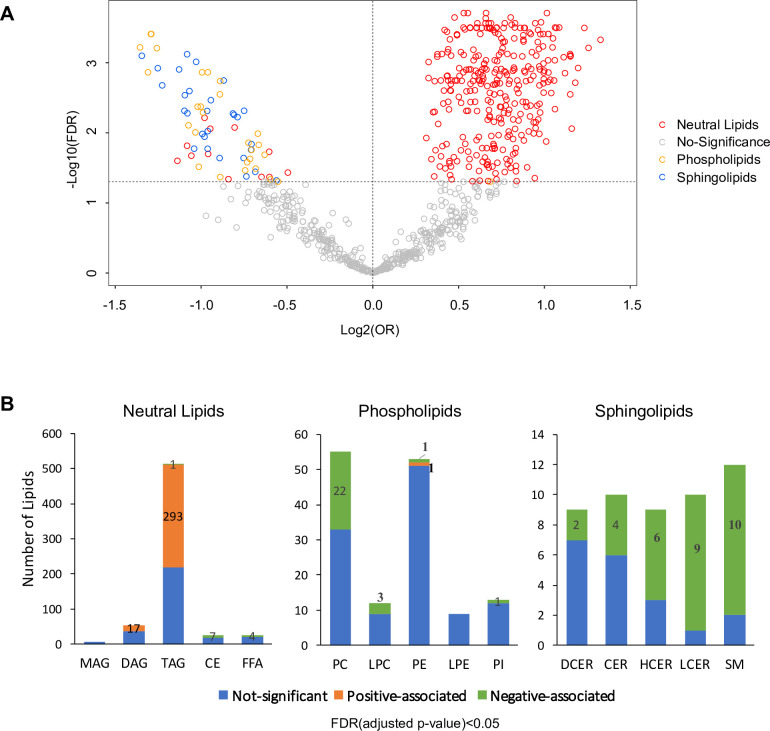
Overview of T2D associated lipids.(A) Volcano plot showed -log10(FDR) against log2(OR) of 816 lipid species in the association with T2D risk. Grey circles were denoted as no significant association with T2D risk. Of those that are significantly associated, red circles denote as neutral lipids, orange as phospholipids, blue as sphingolipids. (B) Number of T2D positive-, negative- and non- associated lipids in each lipid class were shown. Orange, green and blue bars denote positive-, negative- and non- associated lipids respectively. Significance was indicated by FDR < 0.05.Figure 2—source data 1.Odds ratio, 95% CI and FDR values of all lipids. Lipids with FDR < 0.05 were highlighted.